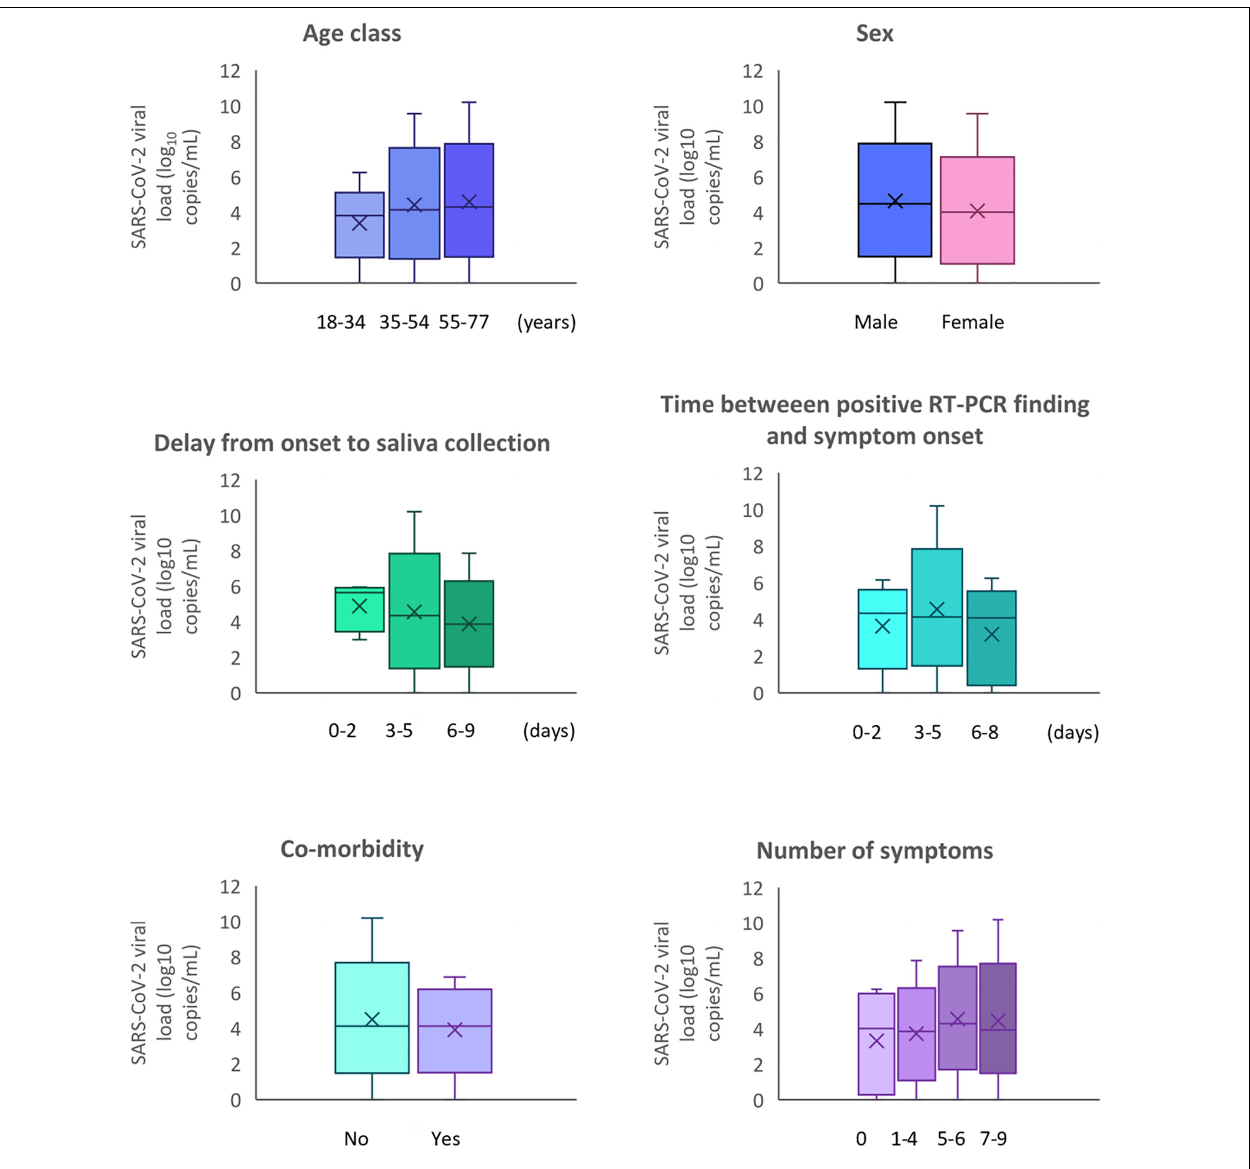
FIGURE 1 | SARS-CoV-2 viral load according to demographics and clinical characteristics of